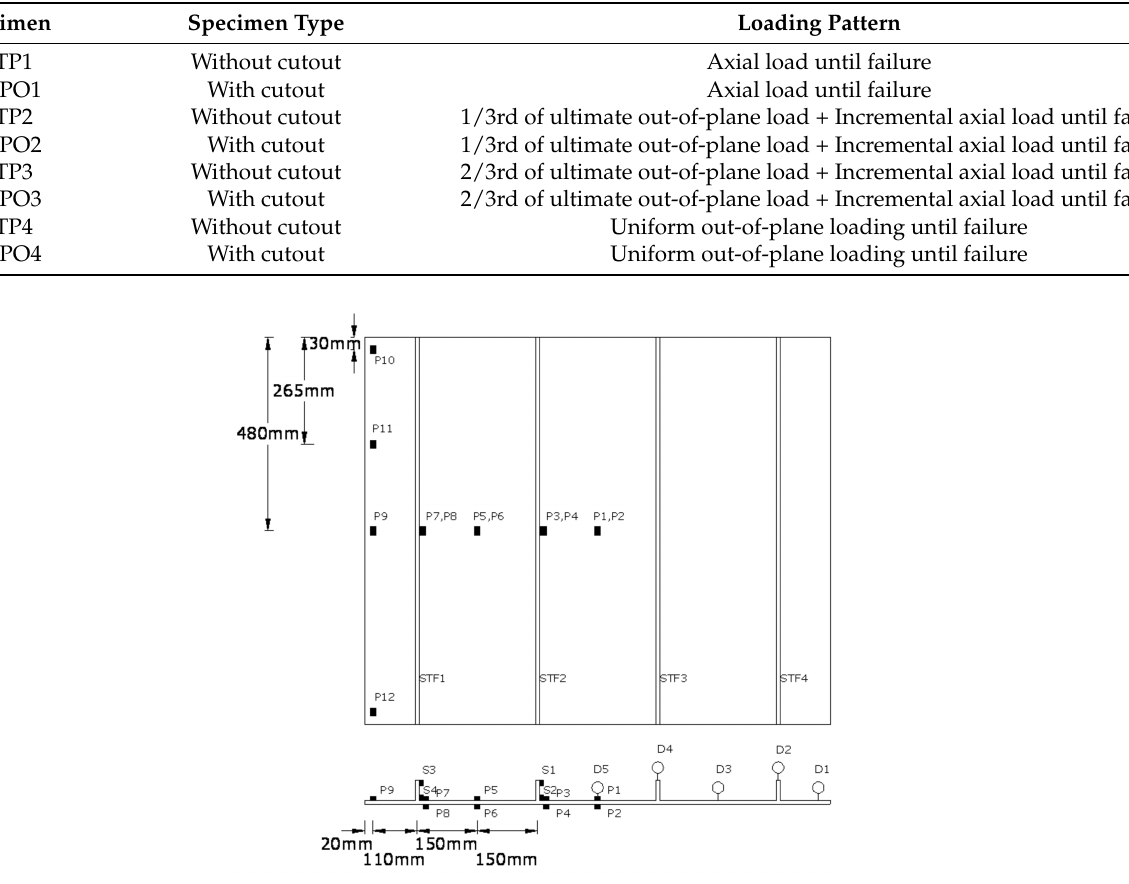
Figure 9. Position of dial and strain gauges. STF1, STF2, STF3, STF4—stiffeners. P1, P2 . . . . P12— Position of strain gauges on flange plate. S1, S2, S3, S4—Position of strain gauges on stiffeners. D1, D2, D3, D4, D5—position of dial